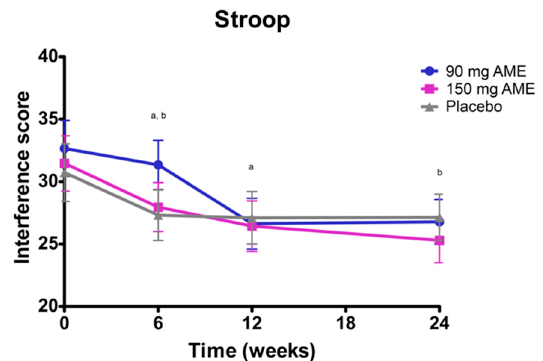
Figure 3. The effect of Aronia melanocarpa extract (AME) supplementation on cognitive flexibility, assessed with the Stroop color and word test. Data are presented as actual mean ± SEM. Analysis was performed with a linear mixed model using estimated means, with correction for baseline values. Post hoc analyses were performed for the factor time. Statistically significant differences between two timepoints are denoted by the letter a or b. Lower scores indicate better performance.